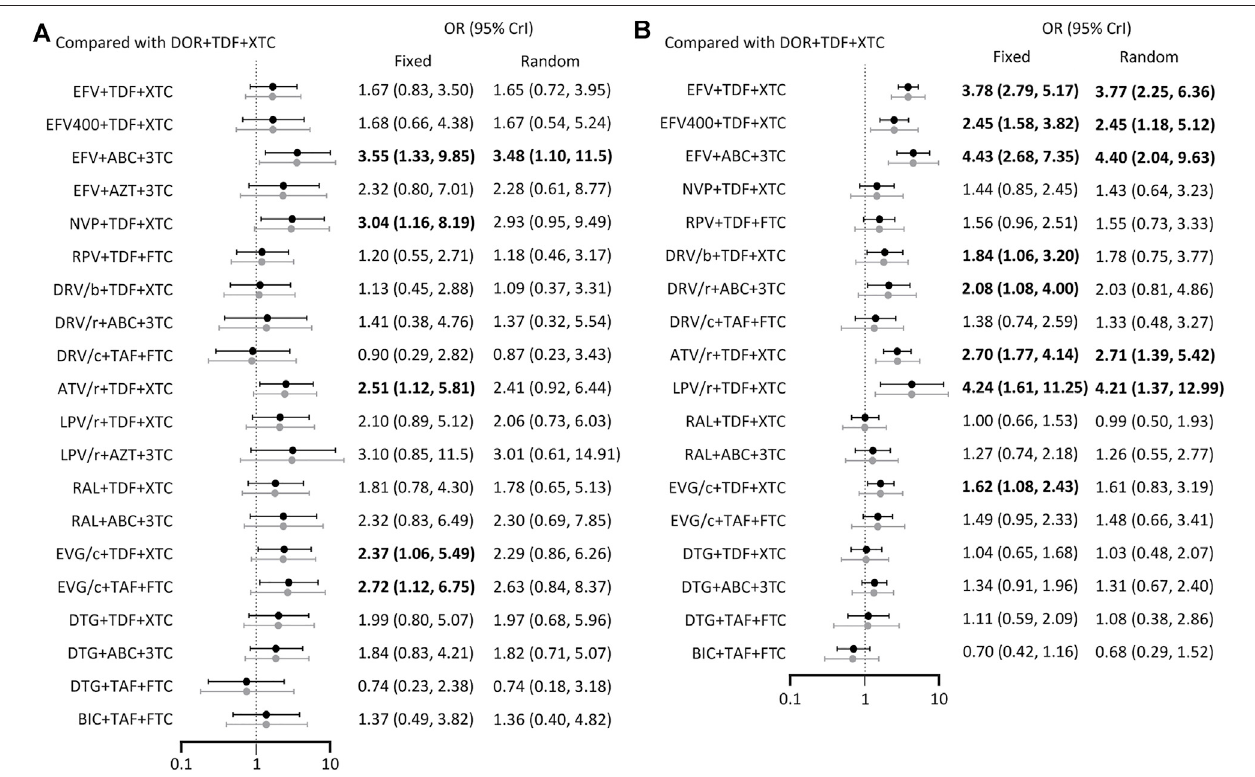
FIGURE4 | Forest plot of outcomes interms of (A) serious adverse events (B) drug-related adverseevents. Resultsof fi xed effect model were drawn in black, and resultsofrandomeffectmodelweredrawningrey.ABC:abacavir;ATV:atazanavir;AZT:Azidothymidine;BIC:bictegravir;c:cobicistat;DOR:doravirine;DRV:darunavir; DTG: dolutegravir; EFV: efavirenz; EVG: elvitegravir; FTC: emtricitabine; LPV: lopinavir; NVP: nevirapine; r: ritonavir; RAL: raltegravir; RPV: rilpivirine; TAF: tenofovir alafenamide; TDF: tenofovir disoproxil fumarate; XTC: emtricitabine or lamivudine; 3TC: lamivudine.